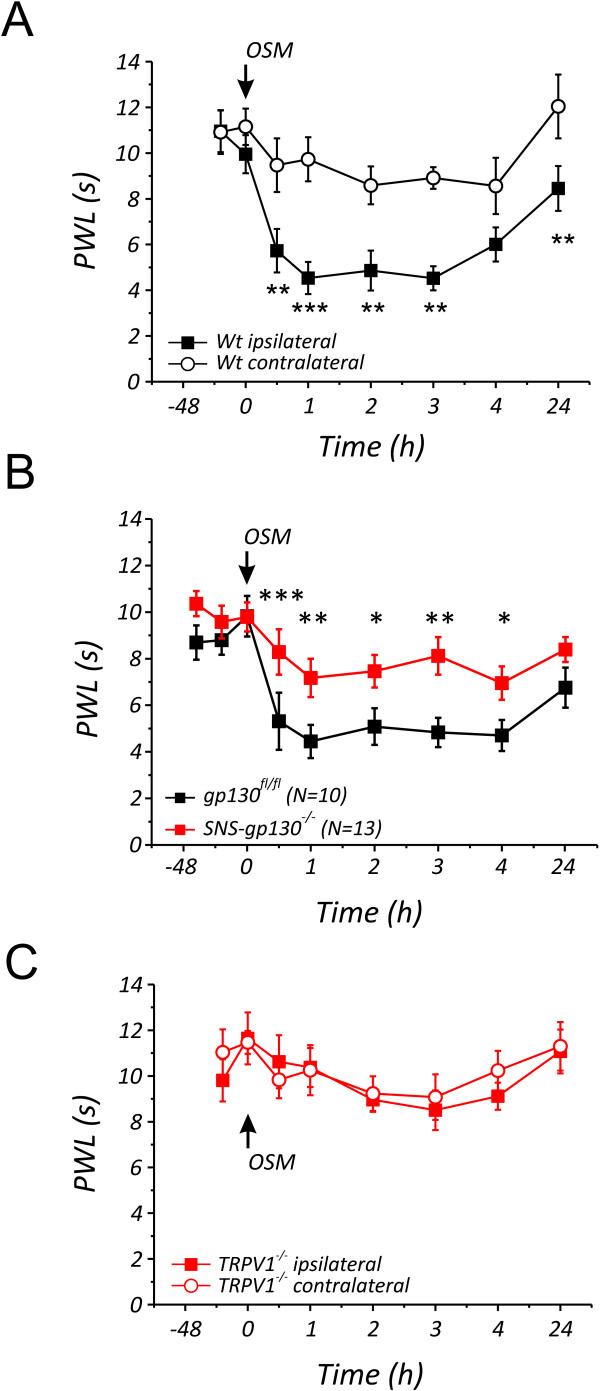
OSM induces thermal hypersensitivity depending on gp130 and TRPV1. (A) Changes in heat sensitivity following hindpaw injection of OSM in C57BL6J wildtype mice. Paw withdrawal latencies were determined at the injected (black squares) and the uninjected hindpaw (black open circles) in response to ramp-shaped heat stimuli and were significantly attenuated at all time points at the ipsilateral site compared to contralateral site (n = 10). (B) Comparison of the PWL between both gp130fl/fl and SNS-gp130-/- mice at the OSM injected hindpaw shows a significant difference; the PWL of gp130fl/fl (black squares, n = 10) are significantly shorter than those of SNS-gp130-/- (red squares, n = 13) starting after 30 minutes until 4 hours after OSM injection. (C) In contrast, the PWL in response to ramp-shaped heat stimuli applied to the plantar side of the hindpaw ipsilateral (red open circle) and contralateral (red squares) of TRPV1-/- mice (n = 11) did not significantly change after OSM injection. * p < 0.05, ** p < 0.01, *** p < 0.001, 2-way repeated ANOVA.